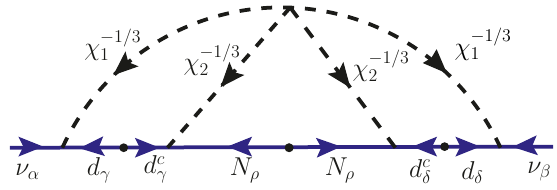
Figure 55 . Three-loop neutrino mass generation in the LQ variant of the KNT model, which induces operator O 11